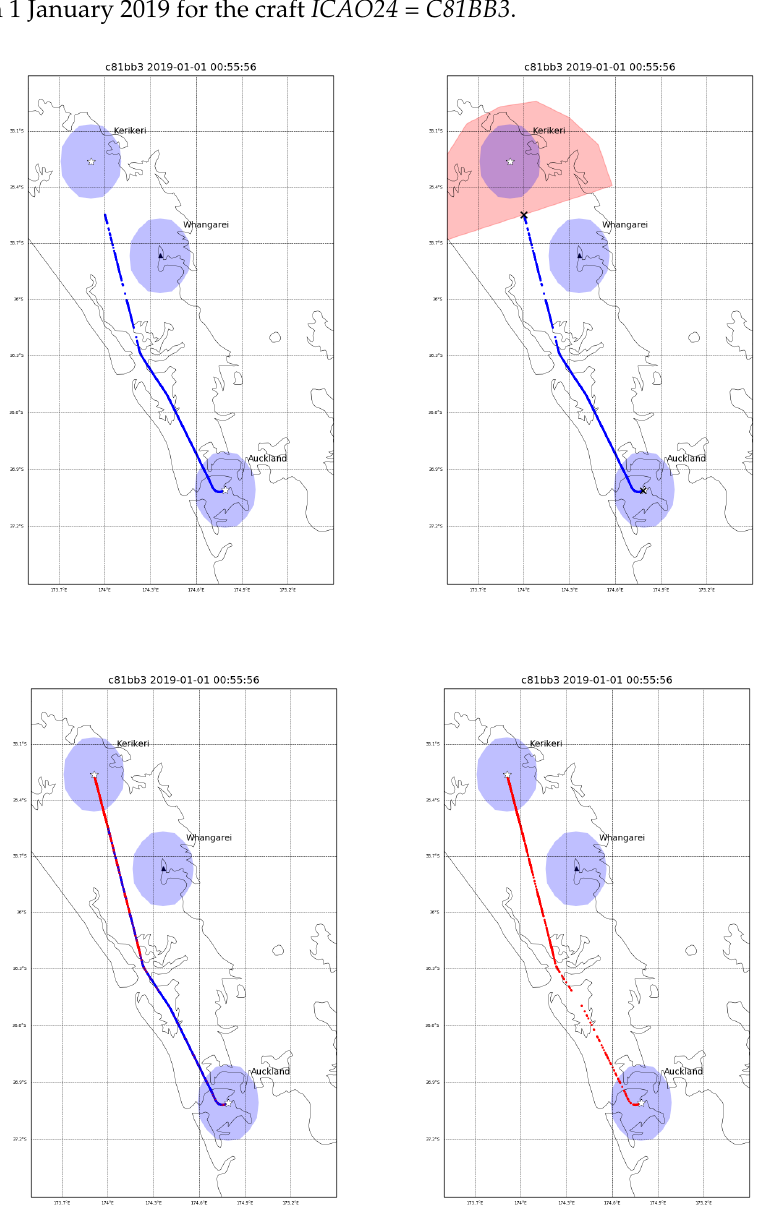
Figure 1. An example of how the state-vector data for an OpenSky flight was extrapolated and interpolated ready for science processing. ( Top left ) A plot of the coordinates (in blue) of a flight from Auckland to Kerikeri. ( Top right ) A schematic of start and end airport derivation for the flight. Blue circles denote a 2 km radius around an airport and the red semicircle denotes the field of view (extending to infinity), based upon craft heading, in which destination airports must fall. ( Bottom left ) The full flight data extrapolated between airports and interpolated down to a 1 s cadence. ( Bottom right ) Only extrapolated and interpolated data for the flight, shown in